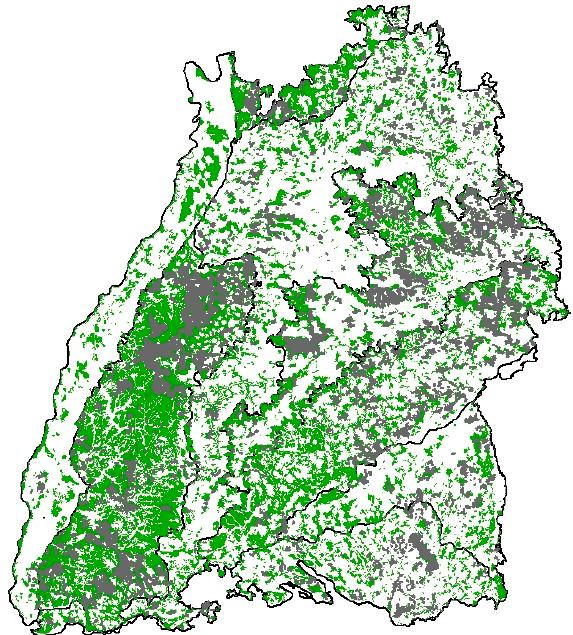
Figure 1. Spatial extent and location of the analyzed area (in grey) in comparison to whole Baden-Württemberg (BW) forest (in green) with the natural regions of third level (black lines), adapted from [55].